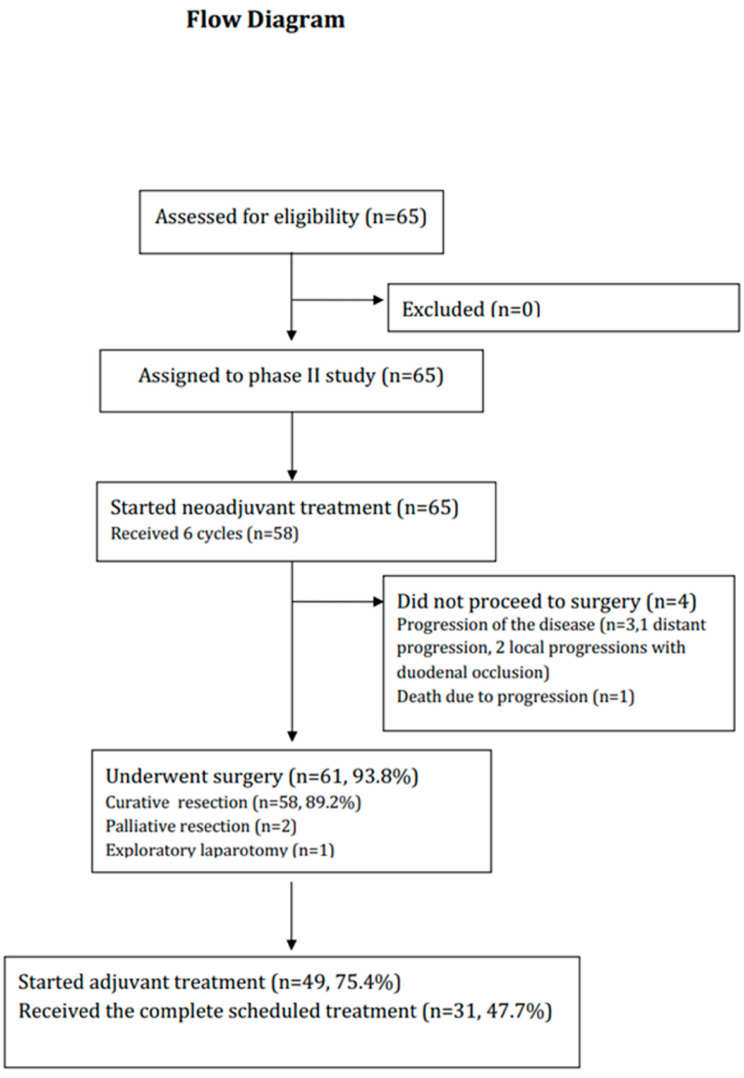
Figure 2. Flow chart of the